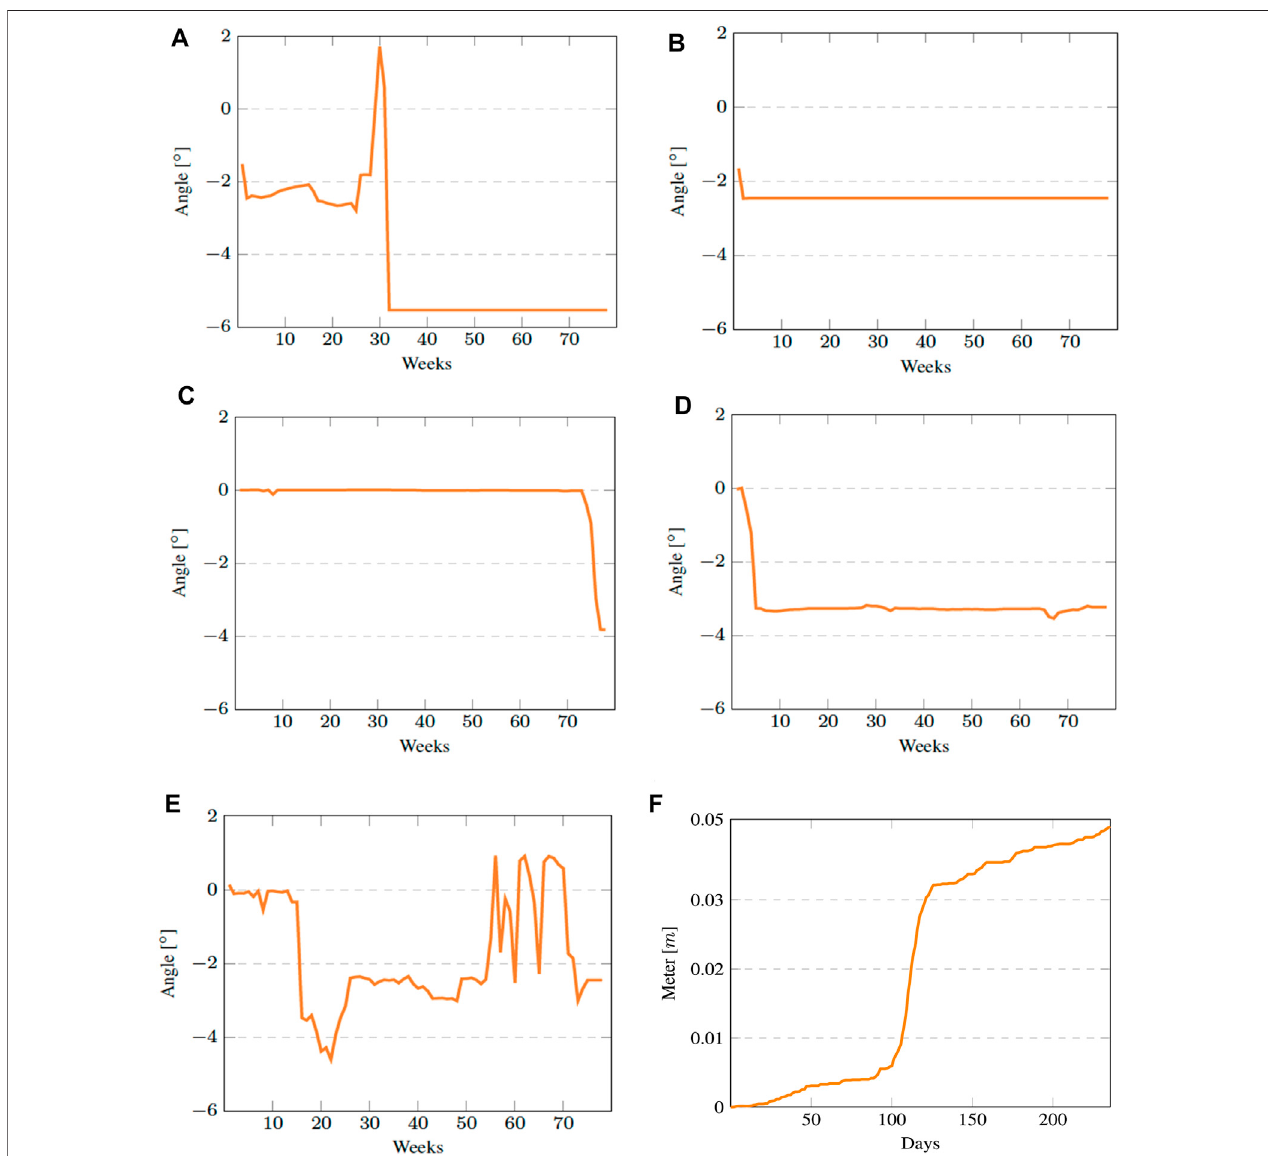
FIGURE3 | The plotsofsoilmovementrecordedfrom sensors deployed at different sites. (A) Sensortilt at 3 min borehole one at Tangni. (B) Sensor tilt at 12 m in borehole two at Tangni. (C) Sensor tilt at 6 m in borehole three at Tangni. (D) Sensor tilt at 15 m in borehole four at Tangni. (E) Sensor tilt at 15 m in borehole fi ve at Tangni. (F) Soil movements (in meters) per day at